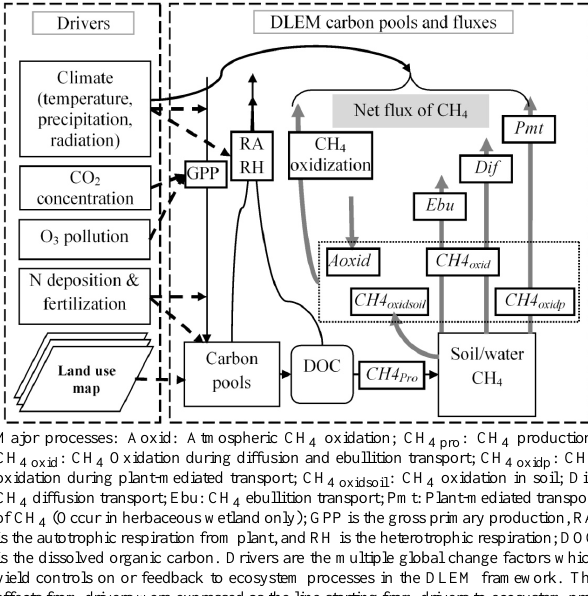
Major processes: Aoxid: Atmospheric CH 4 oxidation; CH 4 pro : CH 4 production; CH 4 oxid : CH 4 Oxidation during diffusion and ebullition transport; CH 4 oxidp : CH 4 oxidation during plant-mediated transport; CH 4 oxidsoil : CH 4 oxidation in soil; Dif: CH 4 diffusion transport; Ebu: CH 4 ebullition transport; Pmt: Plant-mediated transport of CH 4 (Occur in herbaceous wetland only); GPP is the gross primary production, RA is the autotrophic respiration from plant, and RH is the heterotrophic respiration; DOC is the dissolved organic carbon. Drivers are the multiple global change factors which yield controls on or feedback to ecosystem processes in the DLEM framework. The effects from drivers were expressed as the line starting from drivers to ecosystem pro- cesses or pools. Solid lines represent direct, while dash lines represent indirect impacts on CH 4 processes. Fig. 1. Conceptual diagram showing major processes for CH 4 pro- duction, oxidation and transport from the soil/water to the atmo- sphere in response to multiple global change Fig. 1 . Conceptual diagram showing major processes for CH 4 production, oxidation and 2 transport from the soil/water to the atmosphere in response to multiple global change factors 3 4